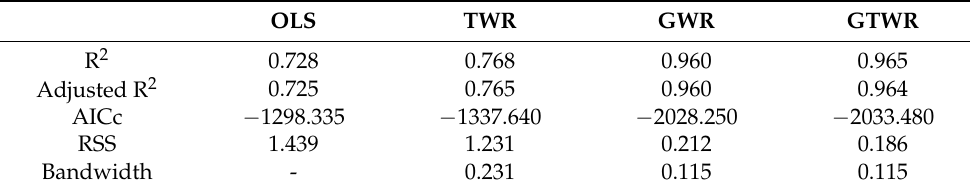
Table 4. Comparison of regression results of the OLS, TWR, GWR, and GTWR models.